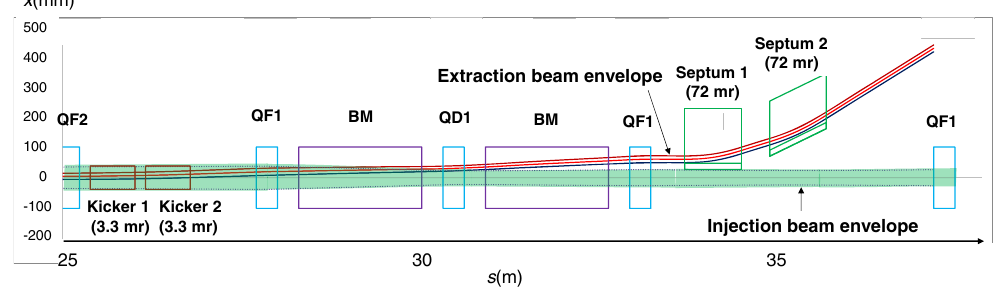
FIG. 5. Beam envelopes in the one-turn extraction